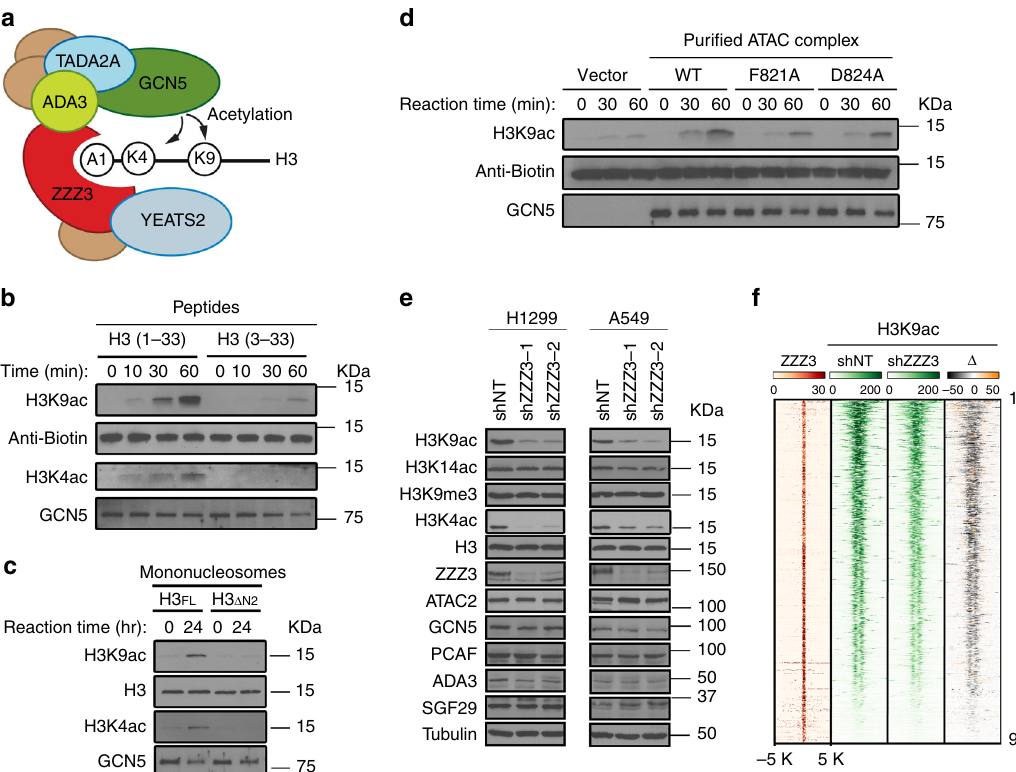
Fig. 3 Recognition of H3 by ZZZ3 is critical for ATAC-dependent histone acetylation. a Schematic of ZZZ3 and the ATAC complex in recognition and acetylation of histone H3 tail. b , c Deletion the fi rst two amino acids (Ala1 – Arg2) of H3 abolishes the HAT activity of the ATAC complex in vitro. Western blot analysis of HAT assays of puri fi ed ATAC complex using the H3 (1 – 33) or H3 (3 – 33) peptides ( b ), or reconstituted mononucleosome containing full- length H3 or H3N Δ 2 proteins ( c ) as substrates. Biotinylated peptides and H3 are shown as loading controls. d Point mutations of ZZ domain attenuate the HAT activity of the ATAC complex in vitro. Western blot analysis of HAT assays of puri fi ed ATAC complexes containing WT or mutant ZZZ3 using H3 (1 – 33) peptide as a substrate. Biotinylated peptides are shown as loading controls. e ZZZ3 KD reduces global H3K9ac and H3K4ac levels in cells. Western blot analysis of the indicated histone modi fi cations and protein levels of ATAC subunits in control (shNT) and ZZZ3 KD (shZZZ3) cells. H3 and tubulin are used as loading controls. f Heatmap pro fi les of ZZZ3 in H1299 cells, H3K9ac in control (shNT) and ZZZ3 KD (shZZZ3) cells, and difference of H3K9ac ( Δ , shZZZ3-shNT). The color key represents the signal density. Gray indicates a reduction in ZZZ3 KD cells compared to the control